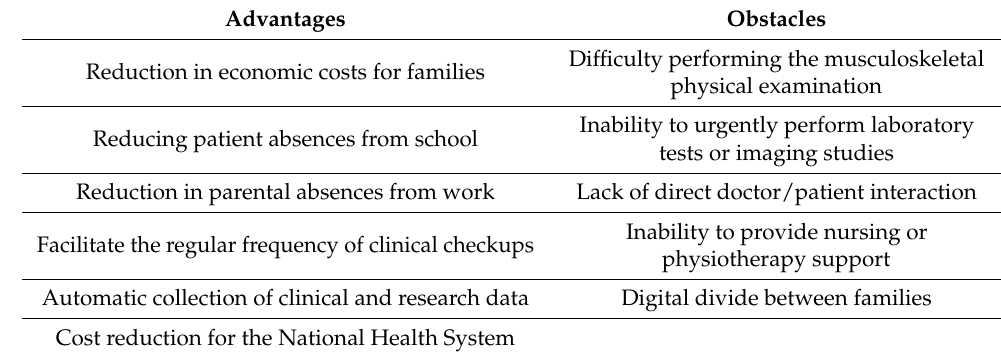
Table 2. The advantages and obstacles related to the application of telemedicine in pediatric rheumatology. Advantages